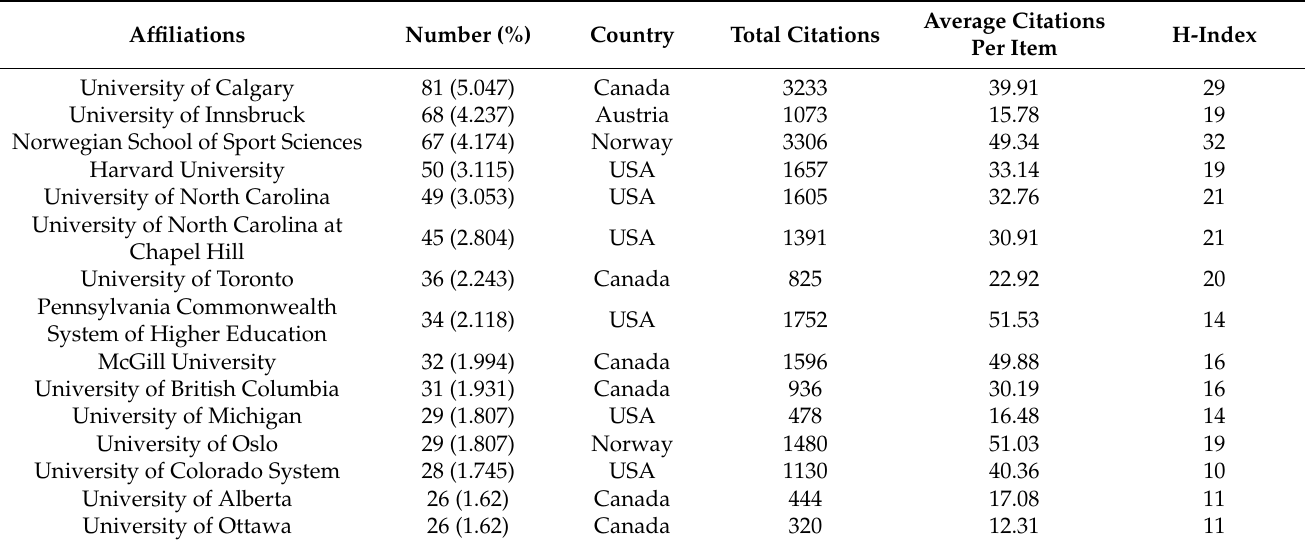
Table 2. The top 15 most published and cited active affiliations in the top 3 research directions related to snow and ice sports injuries.